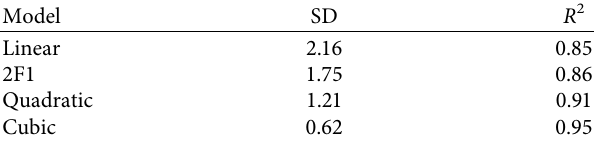
Table 2: Statistical investigation and experimental information.